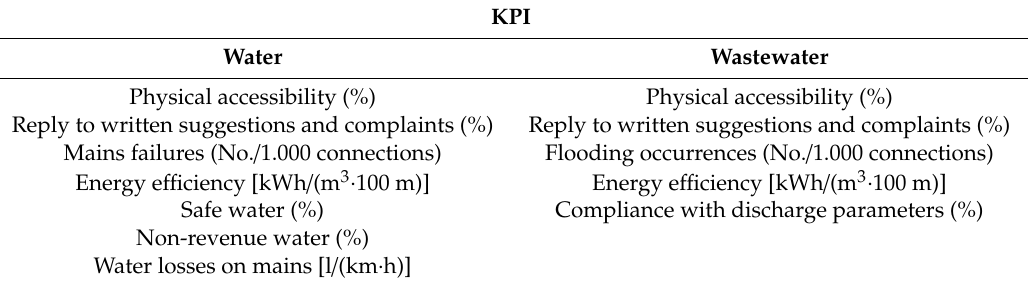
Table 4. Quality of service assessment indicators.